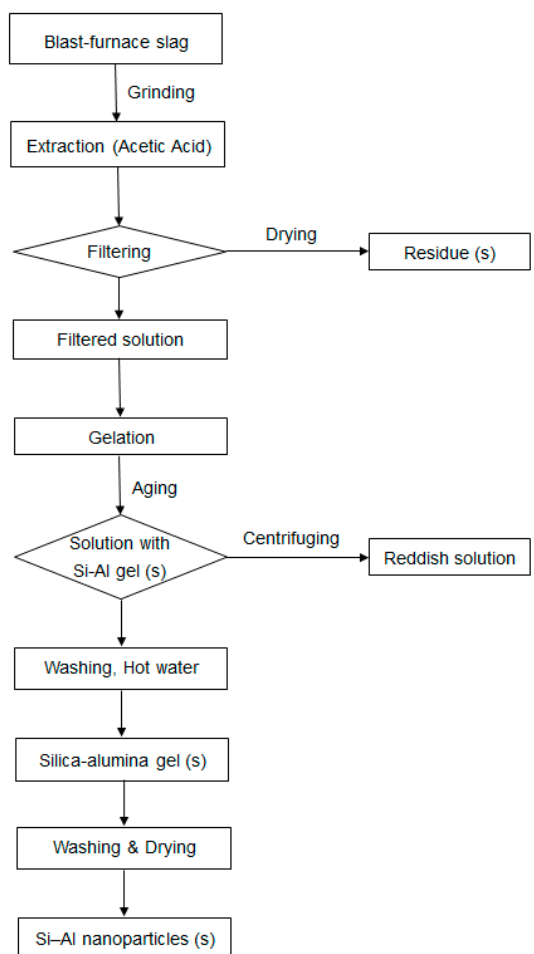
Figure 1. Flowchart for the synthesis of silica-alumina nanoparticles from blast-furnace slag.